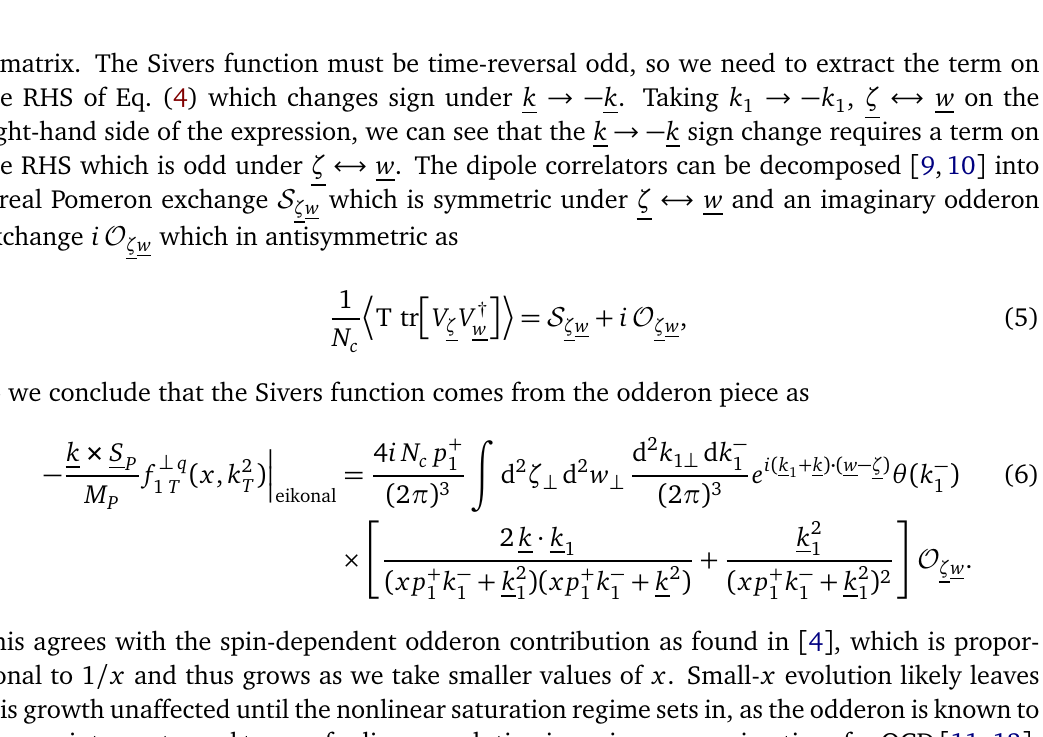
Figure 1: Diagrams of classes B and C with kinematics specified. In the diagram B the antiquark propagates from ζ with momentum k , undergoes a transverse 1 spin-dependent interaction with the proton target at the transverse position w , then propagates to ξ with momentum k . In the diagram C the anti-quark interacts with 2 the shock wave again to the right of the cut, before arriving at the point ξ with momentum k 2